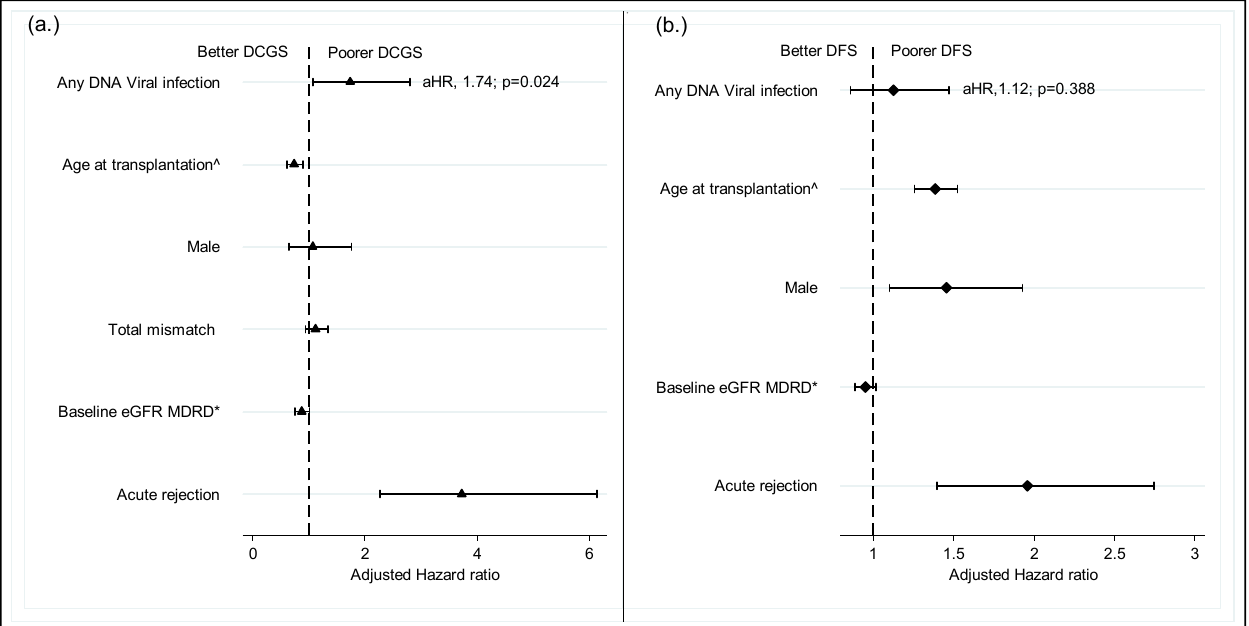
Figure 5. Impact of DNA virus infection on graft survival censored for death. ( a ) Impact of DNA virus infection on graft survival censored for death; ( b ) dialysis free survival. ^ per decade of age; * Per 10 mL/min/1.73 m 2 ; DCGS, death censored graft survival; DFS, dialysis free survival (a composite of graft loss and death with functioning graft; MDRD, modification on diet in renal disease; aHR, adjusted hazard ratio.